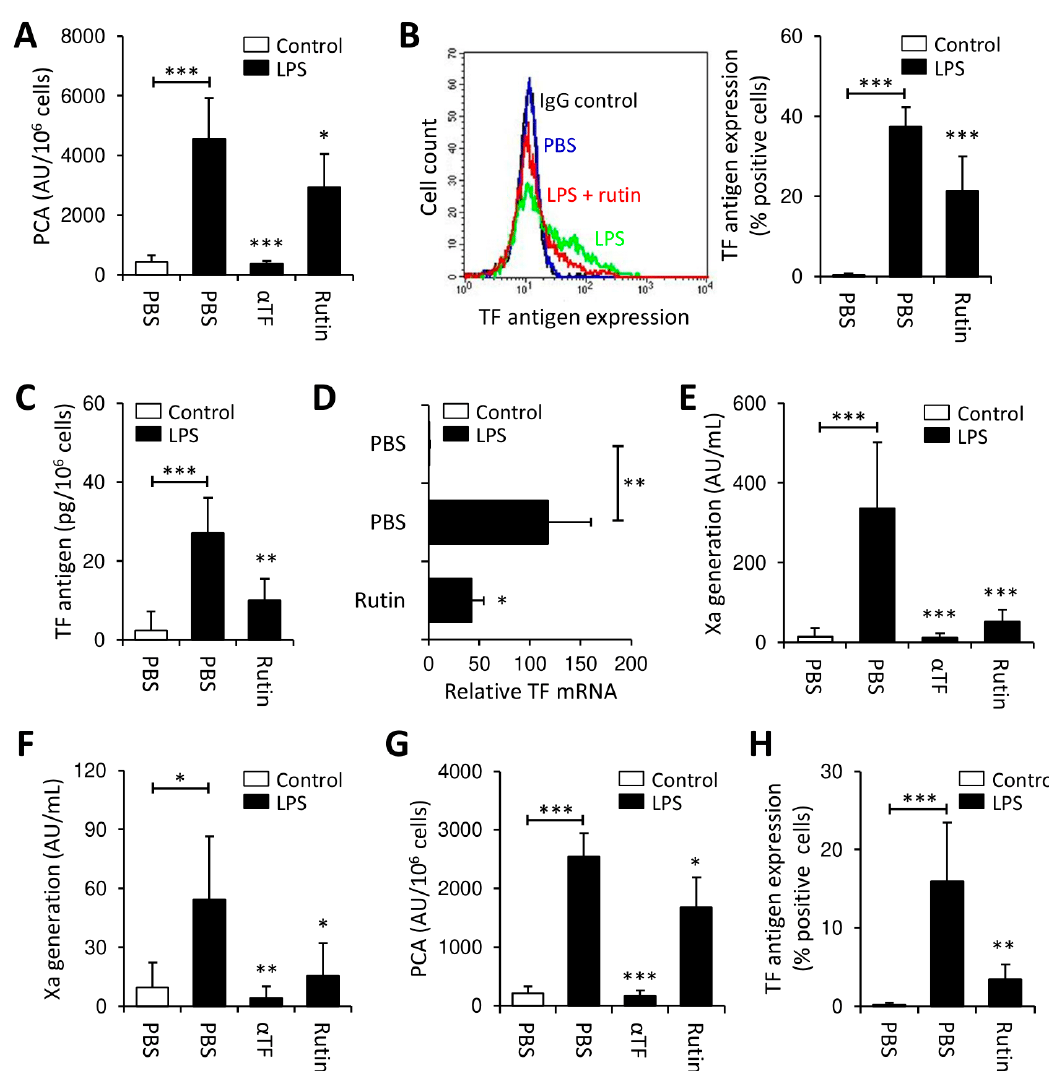
Figure 2. Rutin prevents LPS-induced TF production in PBMCs. ( A – E ) PBMCs were stimulated with LPS (100 ng/mL) in the presence or absence of the thiol isomerase inhibitor rutin (100 µ M) for 2 or 4 h at 37 ◦ C and subsequently analyzed for ( A ) TF PCA by single-stage clotting assay (mean ± SD, n = 13), ( B ) monocyte TF antigen by flow cytometry (mean ± SD, n = 10), ( C ) total cellular TF antigen by ELISA (mean ± SD, n = 6), ( D ) TF mRNA by quantitative RT PCR (mean ± SD, n = 5) and ( E ) release of microvesicle-associated TF PCA by Xa generation assay (mean ± SD, n = 11). ( F , G ) Instead of PBMCs, citrate-anticoagulated whole blood was stimulated with LPS (10 µ g/mL) or PBS in the presence or absence of rutin (100 µ M) for 4 h at 37 ◦ C. ( F ) Microvesicles were isolated from platelet-poor plasma by double high-speed centrifugation and analyzed for TF PCA by chromogenic Xa generation assay (mean ± SD, n = 8). ( G ) PBMCs were isolated by density gradient centrifugation and analyzed for PCA by single-stage clotting assay (mean ± SD, n = 5). ( H ) TF antigen expression on CD14-positive monocytes was measured by flow cytometry (mean ± SD, n = 8). A representative histogram is shown in the Supplementary Materials (Figure S5A). p -values are according to Tukey’s post-hoc test (*, p < 0.05; **, p < 0.01; ***, p <